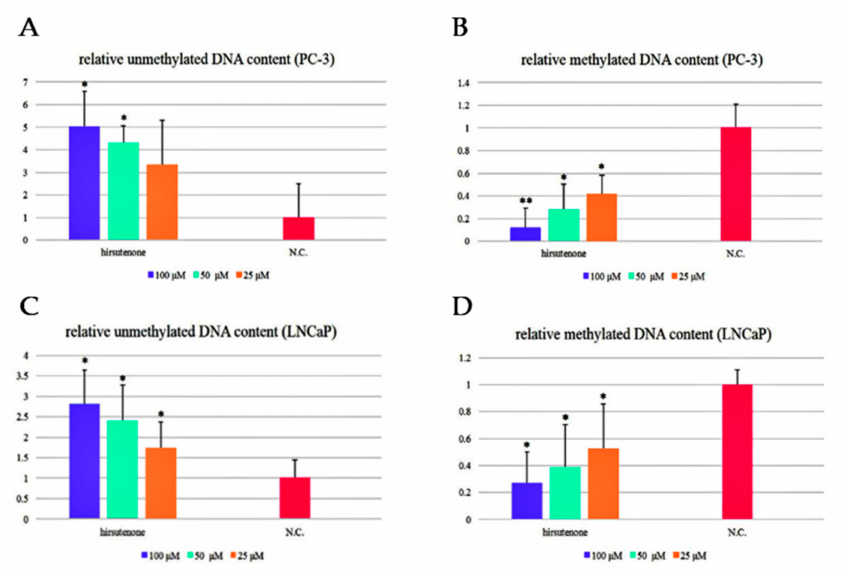
Figure 4. DNA methylation activity of hirsutenone ( 2 ) in PCa cell lines. ( A , C ): relative unmethylated DNA contents in PC-3 and LNCaP cell lines; ( B , D ): relative methylated DNA contents in PC-3 and LNCaP cell lines. The results were expressed as the mean ± SD of triplicate experiments ( n = 3). NC: Normal control group. *: p < 0.05, **: p < 0.01, compared with the normal control